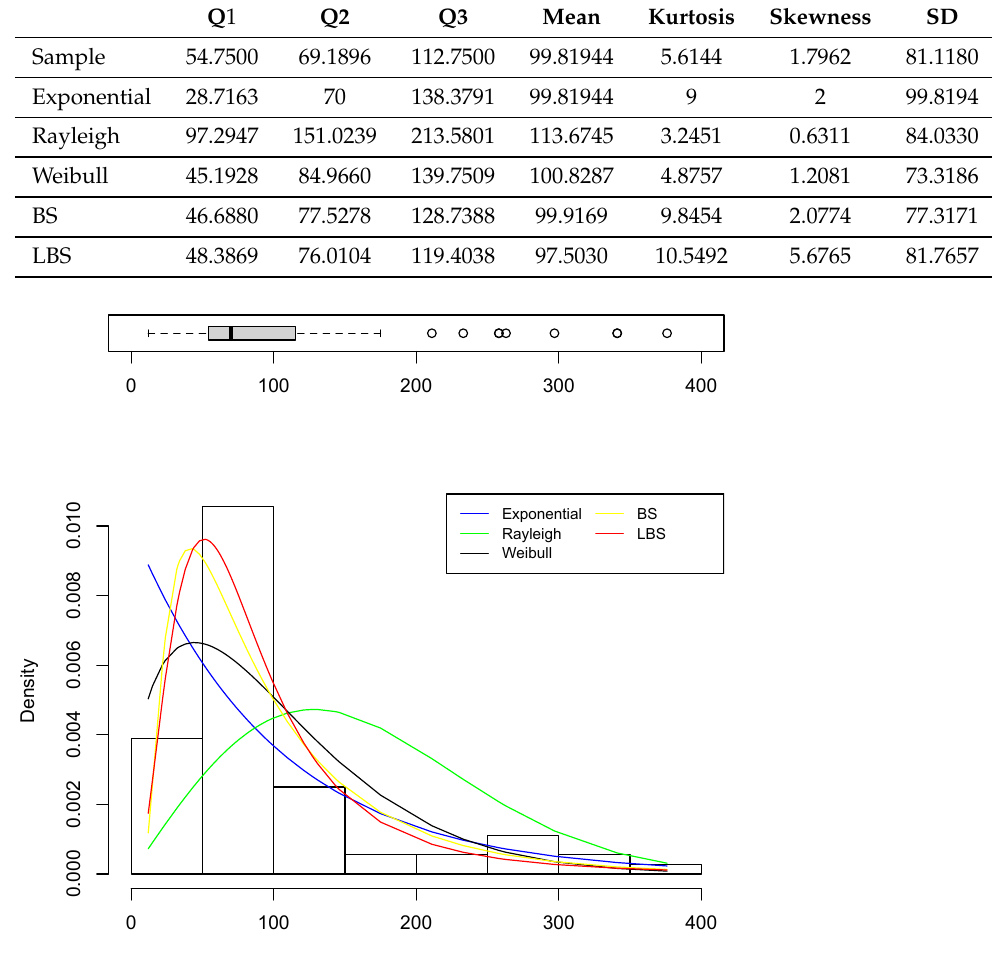
Table 6. EDA outcomes based on Cavia Porcellus data.